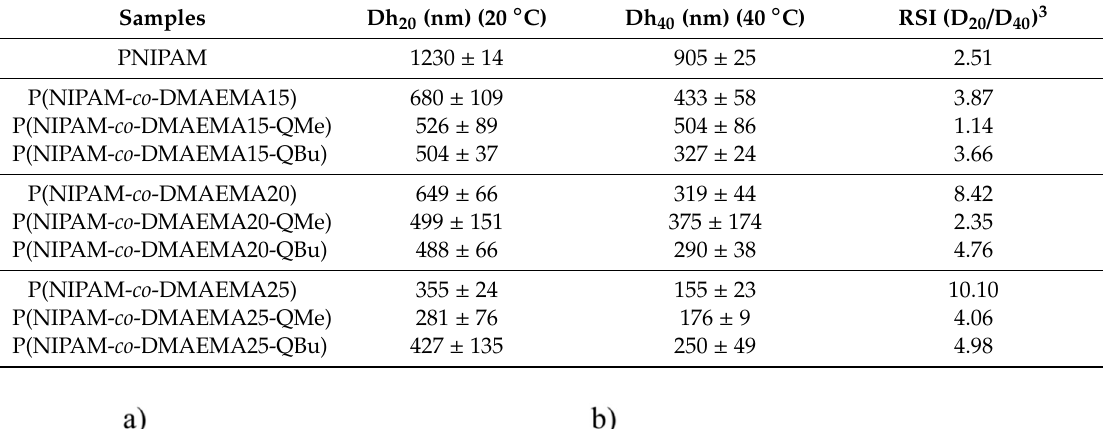
Table 2. Hydrodynamic diameter (Dh) of the studied microgels measured at 20 ◦ C and 40 ◦ C. Determination of the relative swelling index (RSI).